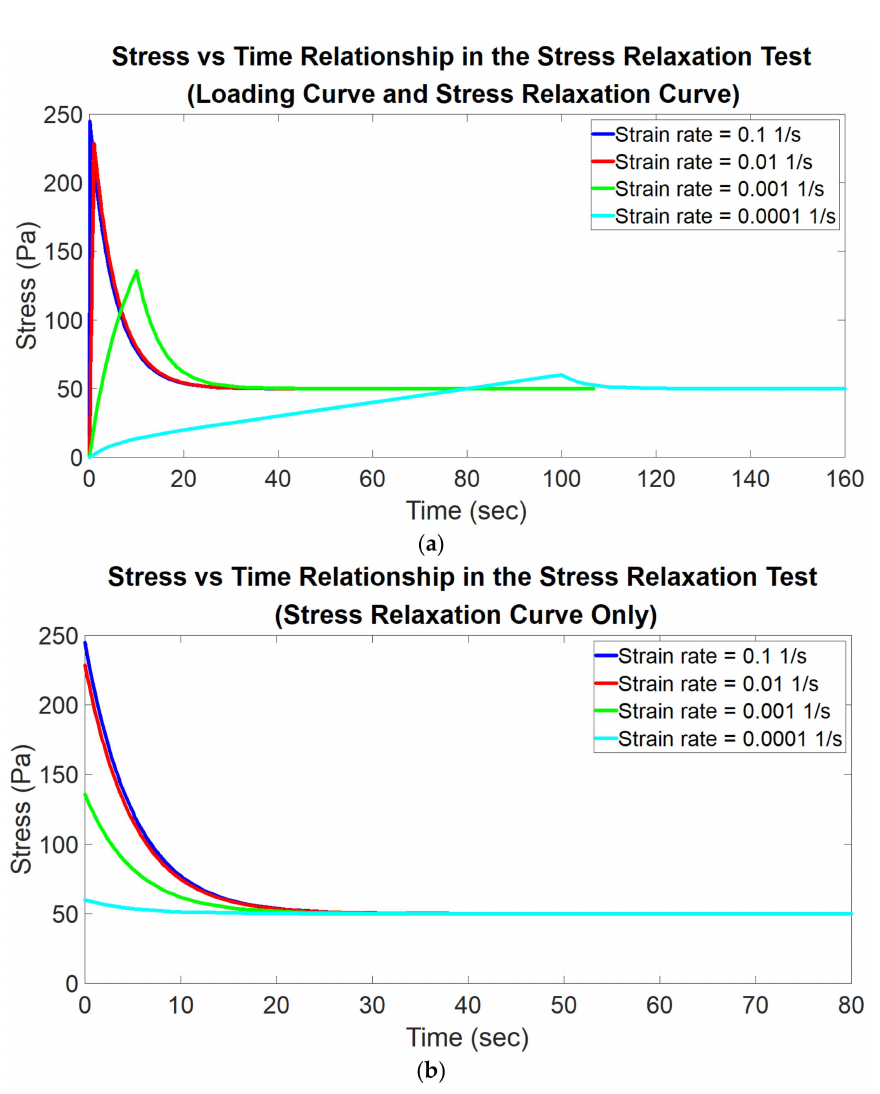
Figure 4. Illustration of an example of a series of simulated stress relaxation curves with associated loading curves measured with different strain rates. ( a ) Loading curve and stress relaxation curve. ( b ) Stress relaxation curve